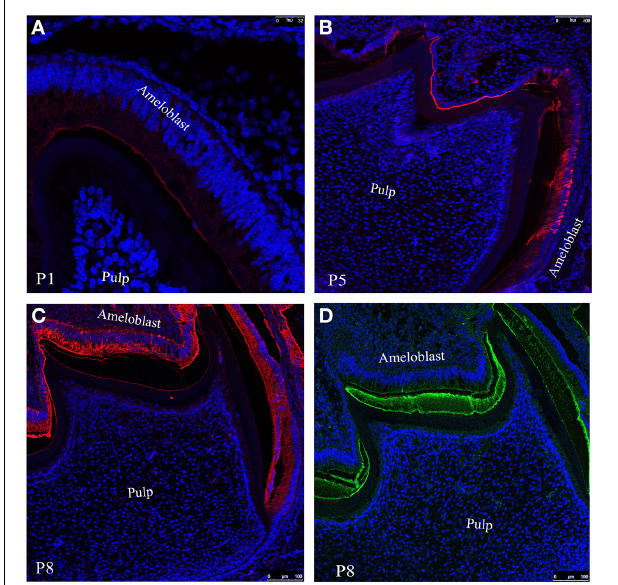
FIGURE 3 | Confocal images of mouse molar enamel showing immunofluorescence of ameloblastin at postnatal days (A) P1, (B) P5 and (C) P8. (D) Represents the immunofluorescence of amelogenin at P8. Nuclei are stained with DAPI (blue).